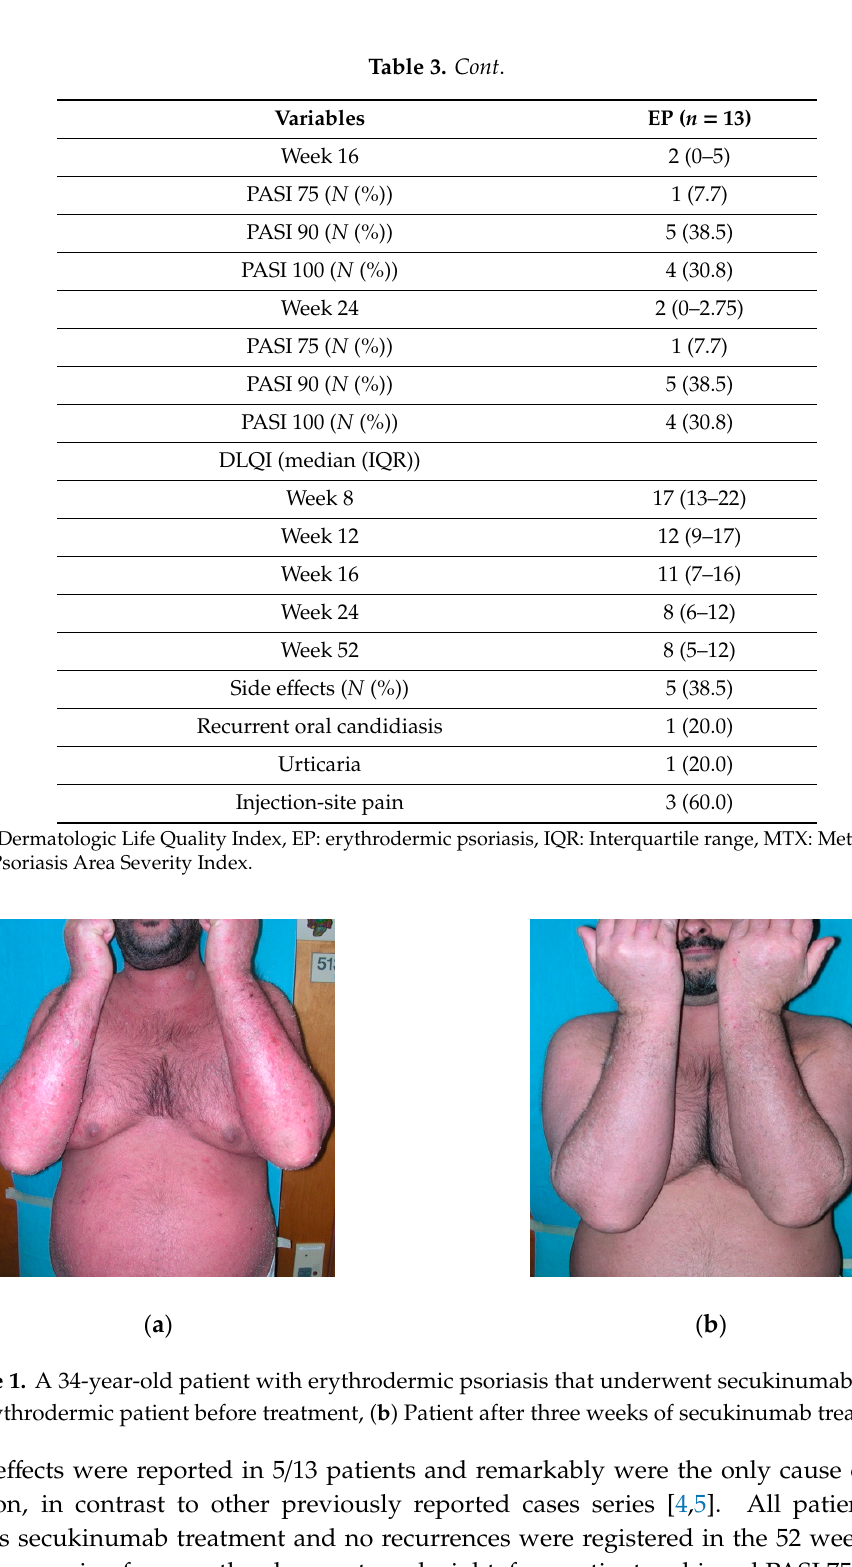
Figure 2. PASI trends in erythrodermic patients from week eight to week 52. * Patients that displayed more than one type of drug use (tobacco, cannabis, alcohol).